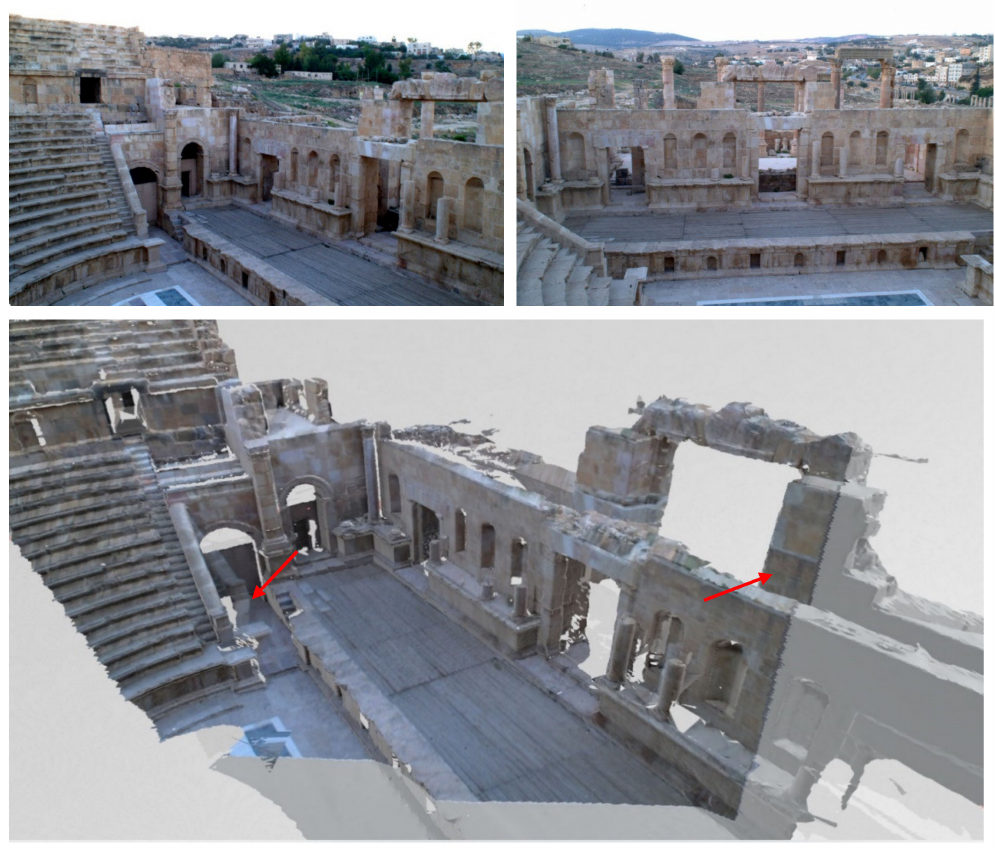
Figure 11. Double mapping e ff ect in texturing the Northern